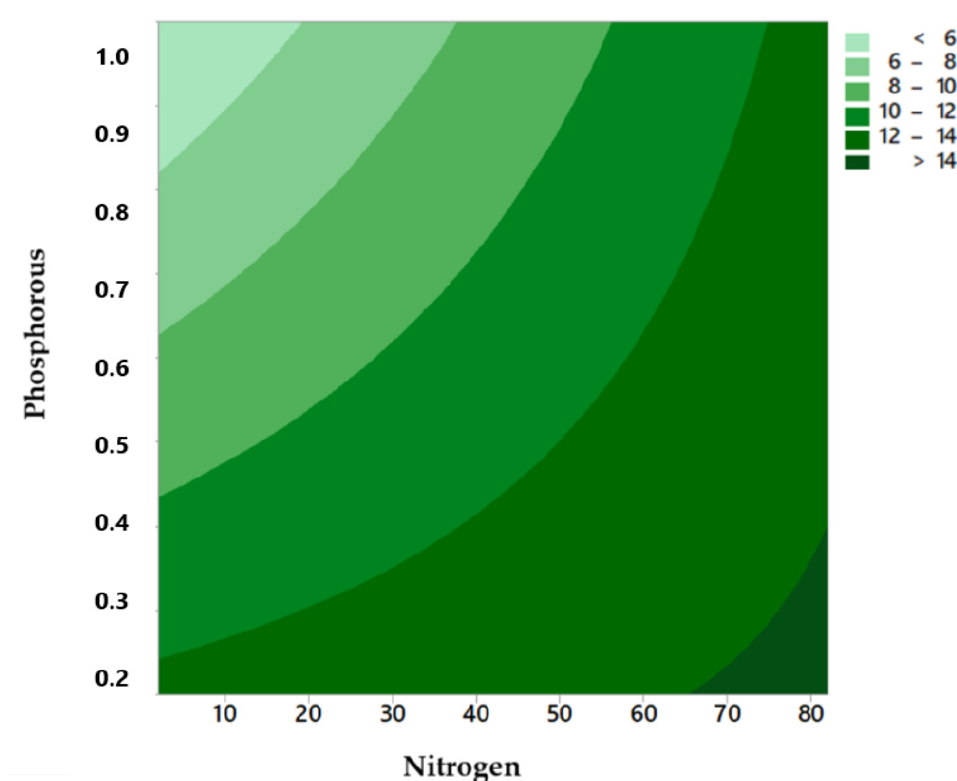
Figure 8. Contour plot of the specific growth rate (SGR) in dry weight (DW) of U. ohnoi at 14 days of culture after the acclimatization phase for the different ppm of N and P.